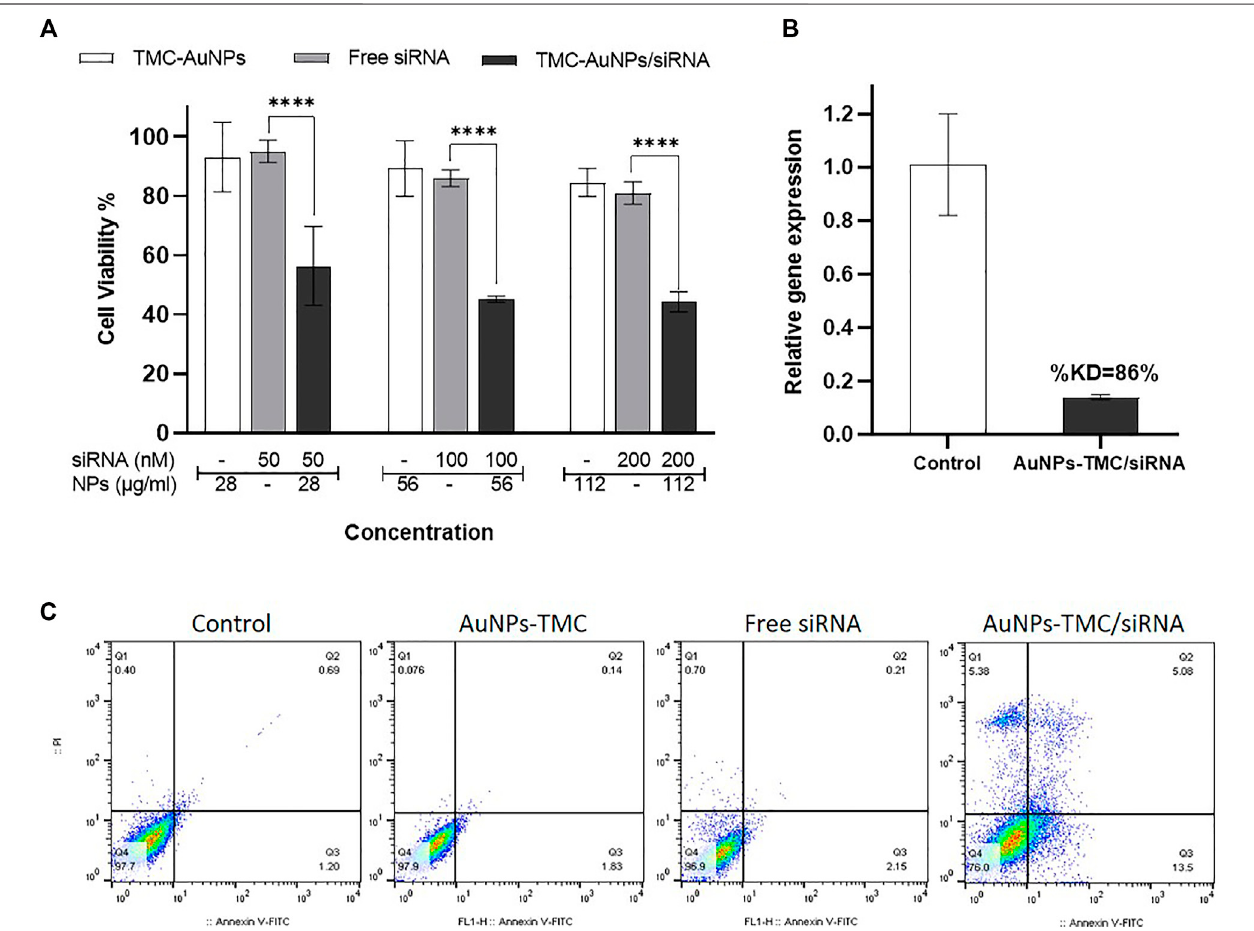
FIGURE3| TherapeuticeffectsofAuNPs-TMC/siRNA. (A) CellviabilitypercentageofMCF-7cellsafter48 hincubationwithAuNPs-TMC,FreesiRNAandAuNPs- TMC/siRNA (w/w ratio 10:1) at different concentration of NPs (28, 56 and 112 μ g/ml) and siRNA (50, 100 and 200 nM). Data is shown as mean ± SD (N = 3). Statistical analysis: Two-way ANOVA, post-test Sidak, (*** p < 0.001 signi fi cantly difference between columns). (B) Relative gene expression percent of EGFR in MCF-7 cells after 24 h incubation with AuNPs-TMC/EGFR-siRNA in w/w ratio of10:1 (56 μ g/ml/100 nM) using RT-PCR method. (KD = knockdown). (C) Apoptosis assay in MCF-7 cancer cells following no treatment and treatment with AuNPs-TMC, Free siRNA and AuNPs-TMC/EGFR-siRNA (56 μ g/ml/100 nM) after 24 h using annexin V-FITC/PI staining.